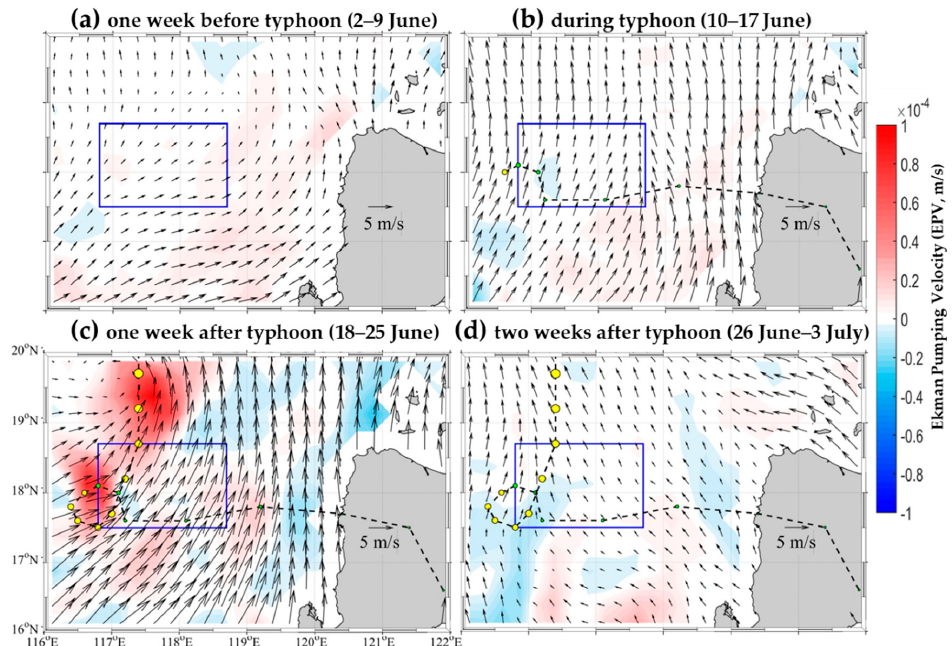
Figure 4. Distribution map of the Ekman pumping velocities (EPV, m/s) and wind fields before and after the typhoon ( a ) one week before typhoon; ( b ) during typhoon; ( c ) one week after typhoon; ( d ) two weeks after typhoon; the blue box indicates the study area, the black dotted line indicates the typhoon path, and the arrows indicate the wind vectors).